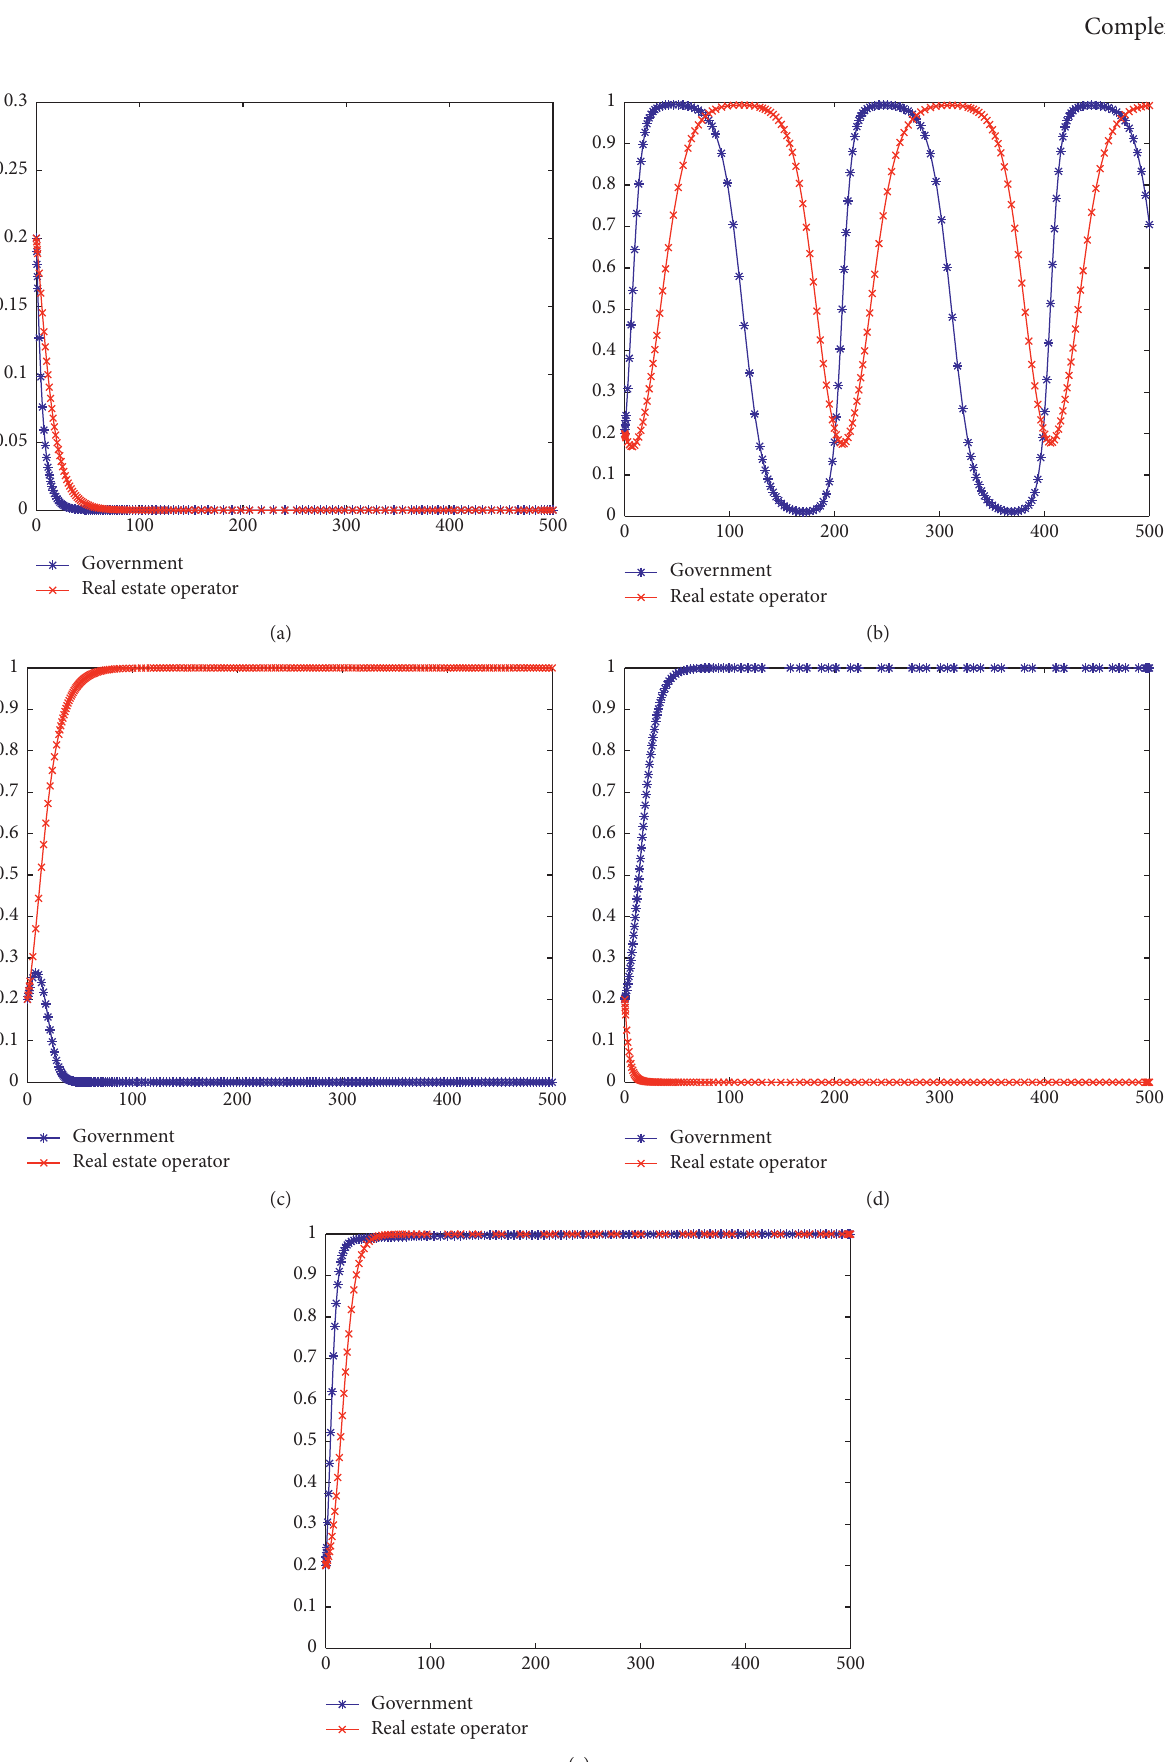
Figure 3: Government’s and real estate operators’ strategic evolutionary roadmaps with different levels of financial institutions and public involvement in